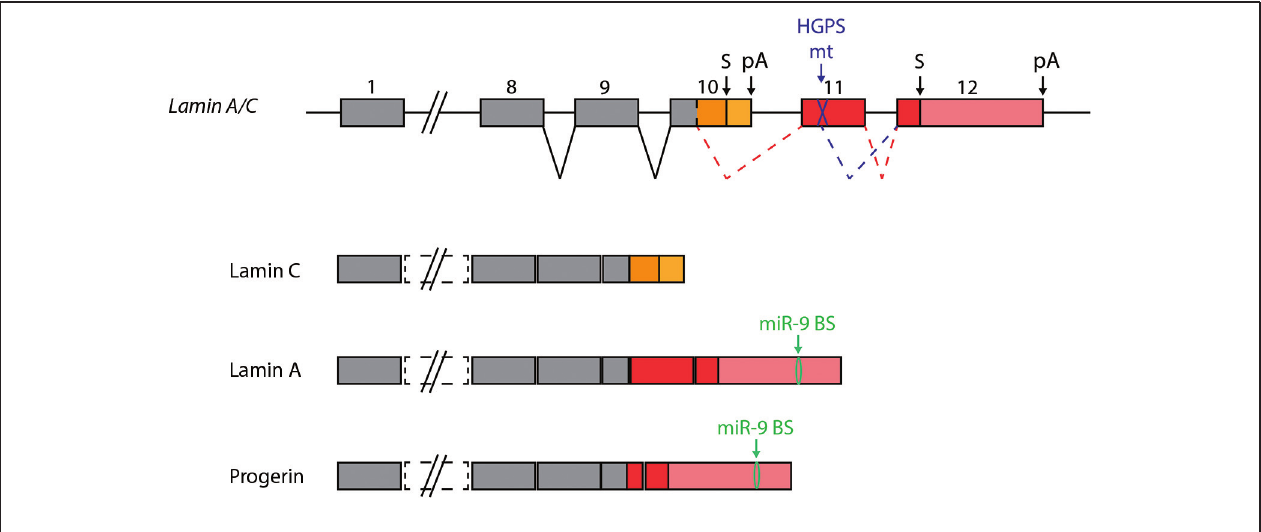
FIGURE 4 | miR-9 protects the brain from Progerin . Two alternative transcripts are generated from the the Lamin A/C gene, encoding Lamin C and Lamin A proteins. HGPS is caused by a mutation in exon 11, which is specific to Lamin A encoding transcripts. The mutation generates an additional splice site, which leads to the generation of a new transcript